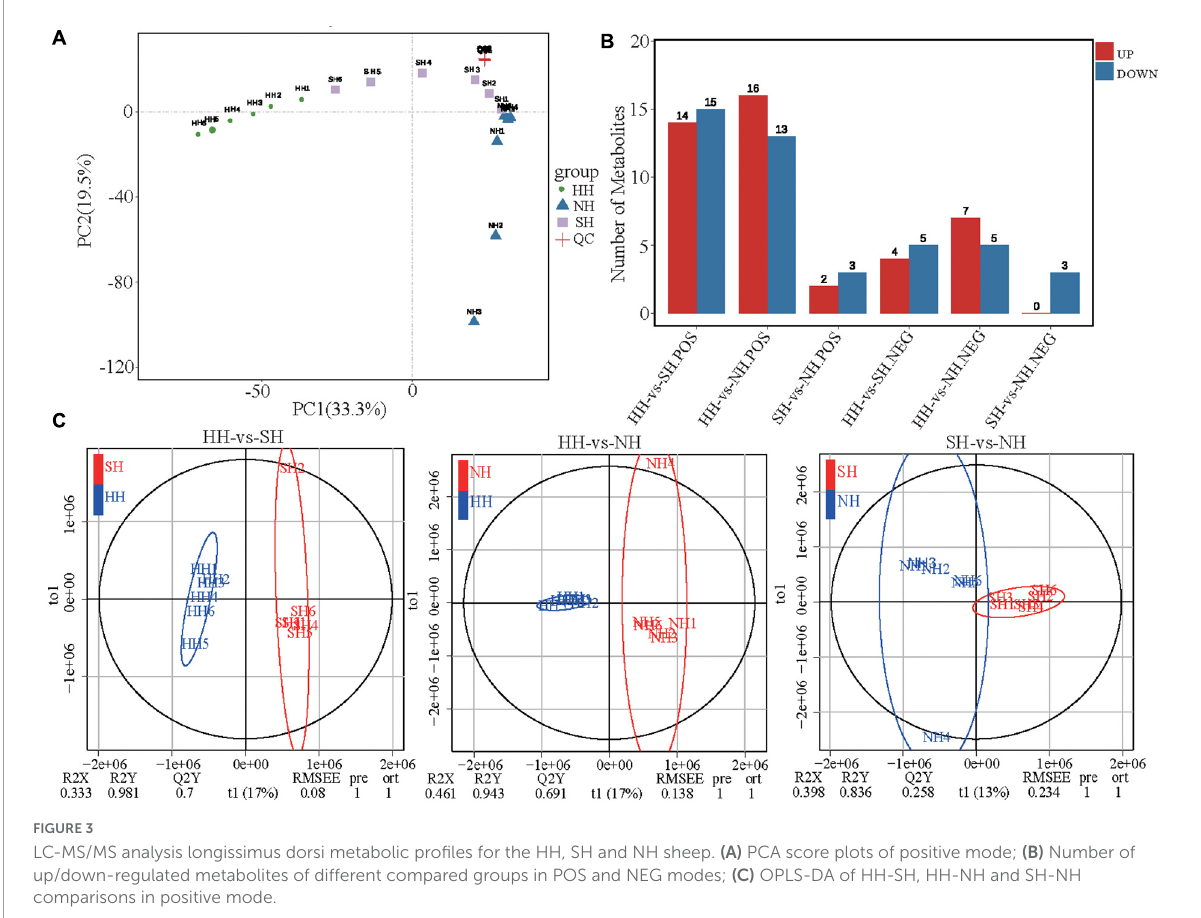
FIGURE3 LC-MS/MS analysis longissimus dorsi metabolic profiles for the HH, SH and NH sheep. (A) PCA score plots of positive mode; (B) Number of up/down-regulated metabolites of different compared groups in POS and NEG modes; (C) OPLS-DA of HH-SH, HH-NH and SH-NH comparisons in positive mode.